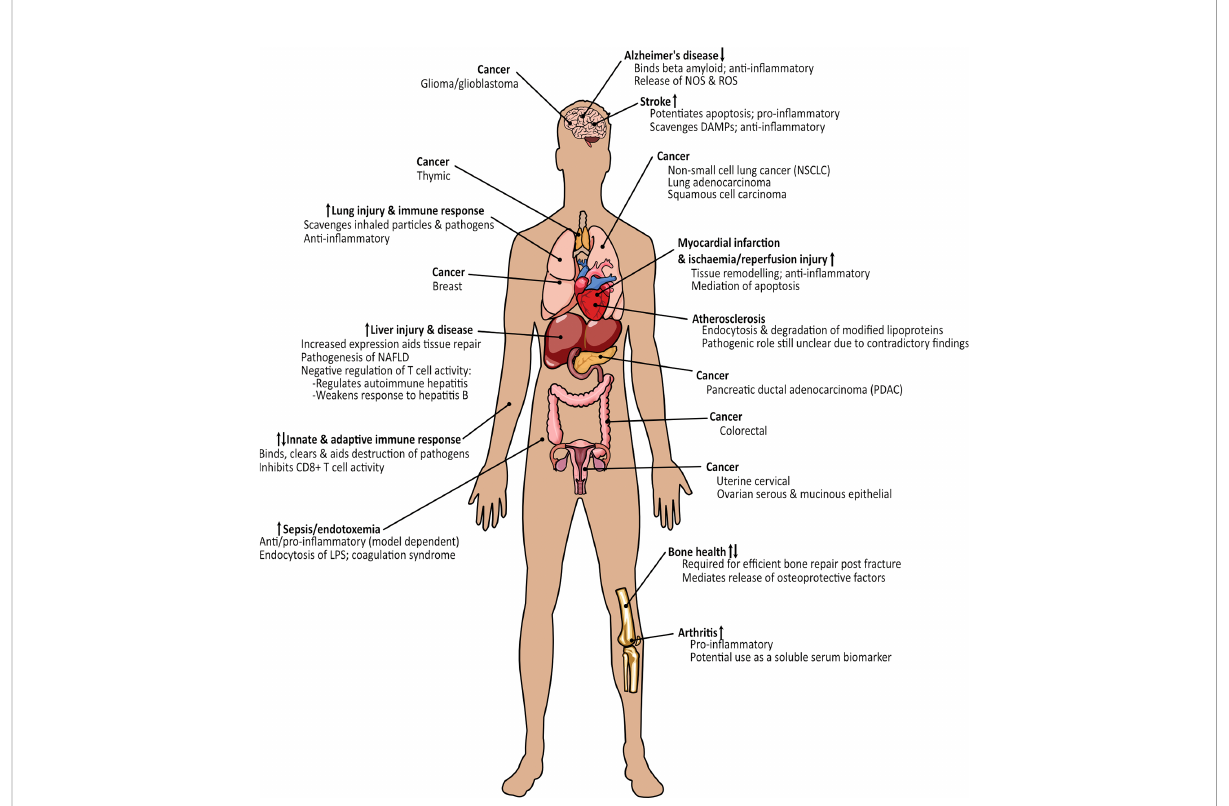
FIGURE 10 Overview of the processes and diseases where MSR1 holds either a protective or damaging function. Arrows indicate whether expression of MSR1 is increased or